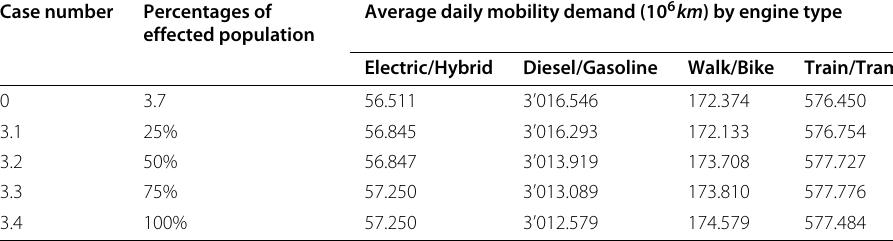
Table 6 Result of daily average mobility demand (10 6 km ) by engine type in scenarios of climate